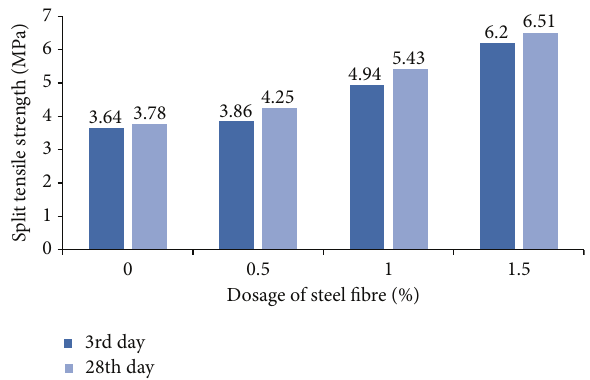
Figure10:Flexuralstrengthofvariousvolumefractionsofsteelfibre reinforced geopolymer concrete